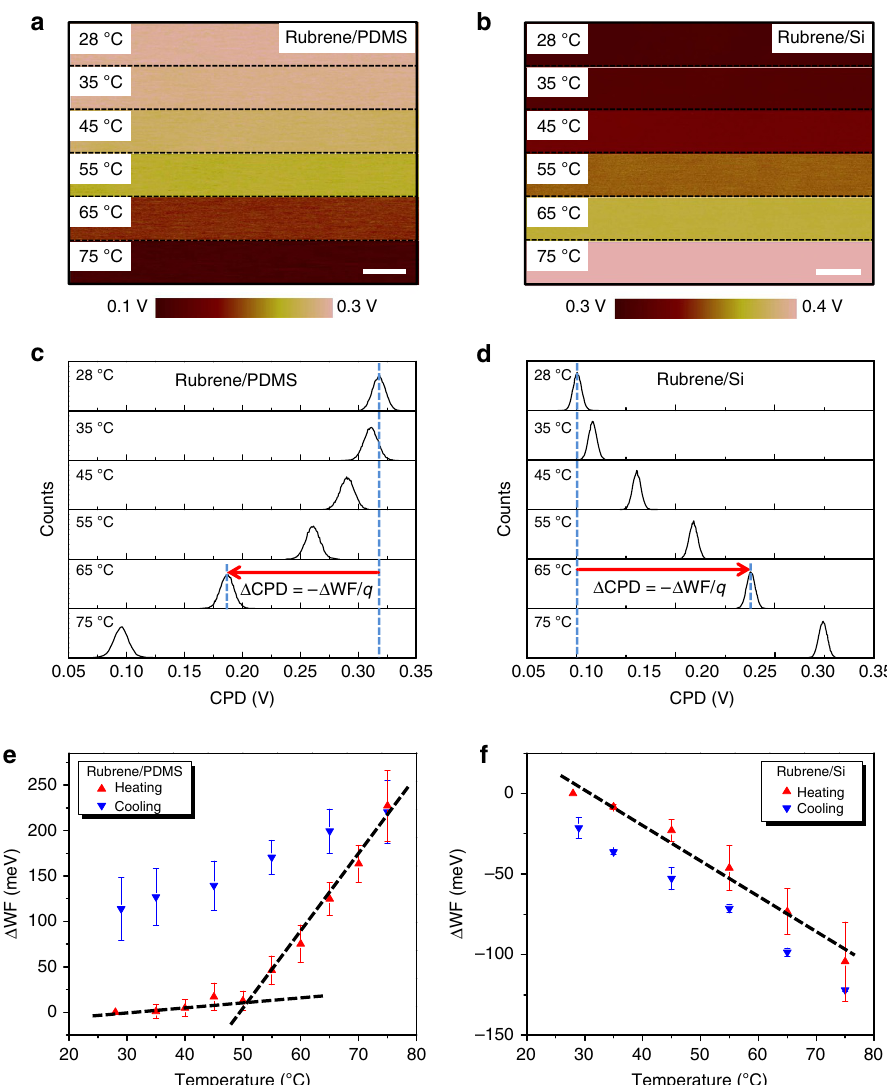
Figure 4 | SKPM measurements of rubrene as a function of temperature. ( a ) CPD of rubrene on PDMS shifts from more positive (bright) to more negative (dark) when the sample is heated from room temperature to 75 (cid:2) C. Length of scale bar is 500nm. ( b ) CPD of rubrene on Si shifts from more negative (dark) to more positive (bright) when the sample is heated from room temperature to 75 (cid:2) C. Length of scale bar, 500nm. ( c ) CPD histograms extracted from images in a . D CPD, indicated by the red arrow, is defined as the change of CPD at any elevated temperature from that at room temperature, that is, D CPD ¼ CPD(T) (cid:2) CPD(r.t.). ( d ) CPD histograms extracted from images in b . ( e ) Average D WF of rubrene on PDMS as a function of temperature with D WF defined as (cid:2) q D CPD, where q is the elementary charge. The dashed lines show two distinct regimes of D WF at low and high temperatures. The error bars in D WF were based on the s.d. of 24 independent measurements from four different samples at each temperature. ( f ) Average D WF of rubrene on Si as a function of temperature. The dashed line shows continuous change of D WF within the entire temperature range. The error bars in D WF were based on s.d. of 12 independent measurements from two different samples at each